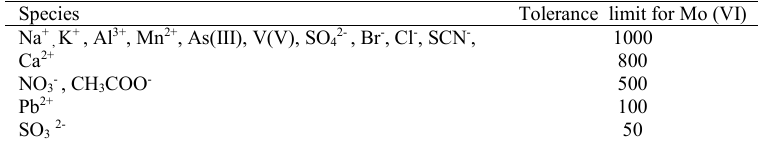
Table 1: Tolerance ratio of interfering ions in the determination of 0.9 µg mL -1 of molybdenum.